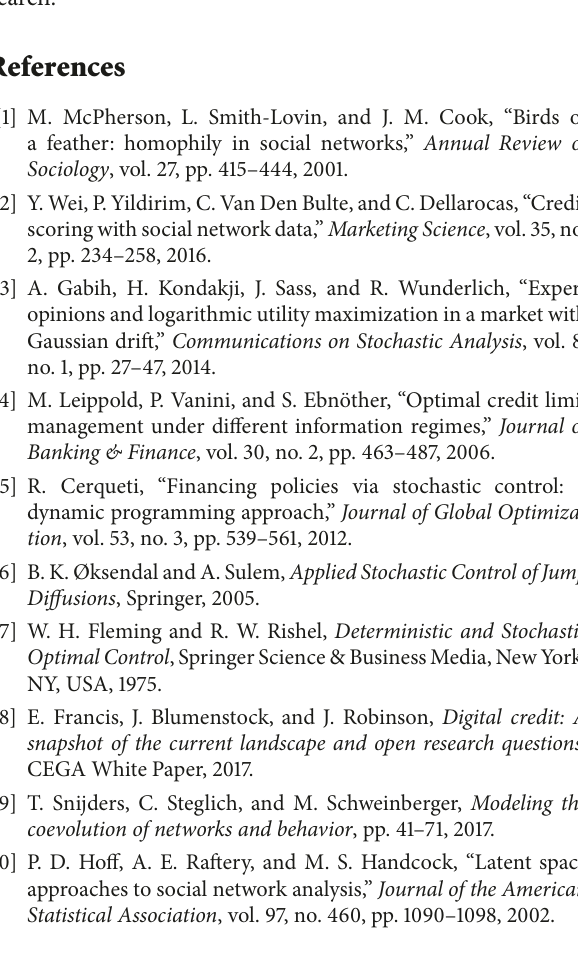
𝑡 when no. of friends